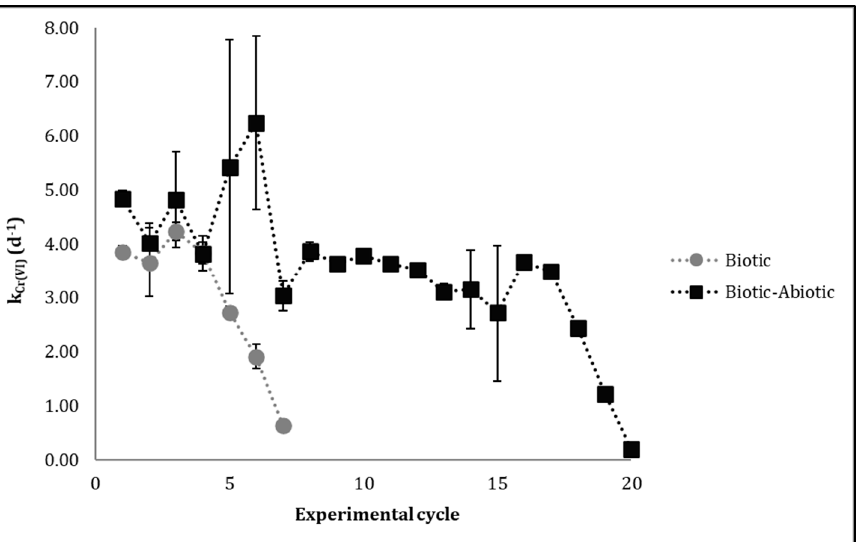
Figure 6. Time profiles of Cr(VI) reduction rates in the Biotic and Biotic-Abiotic experiments for each experimental cycle (error bars are equal to standard deviation).